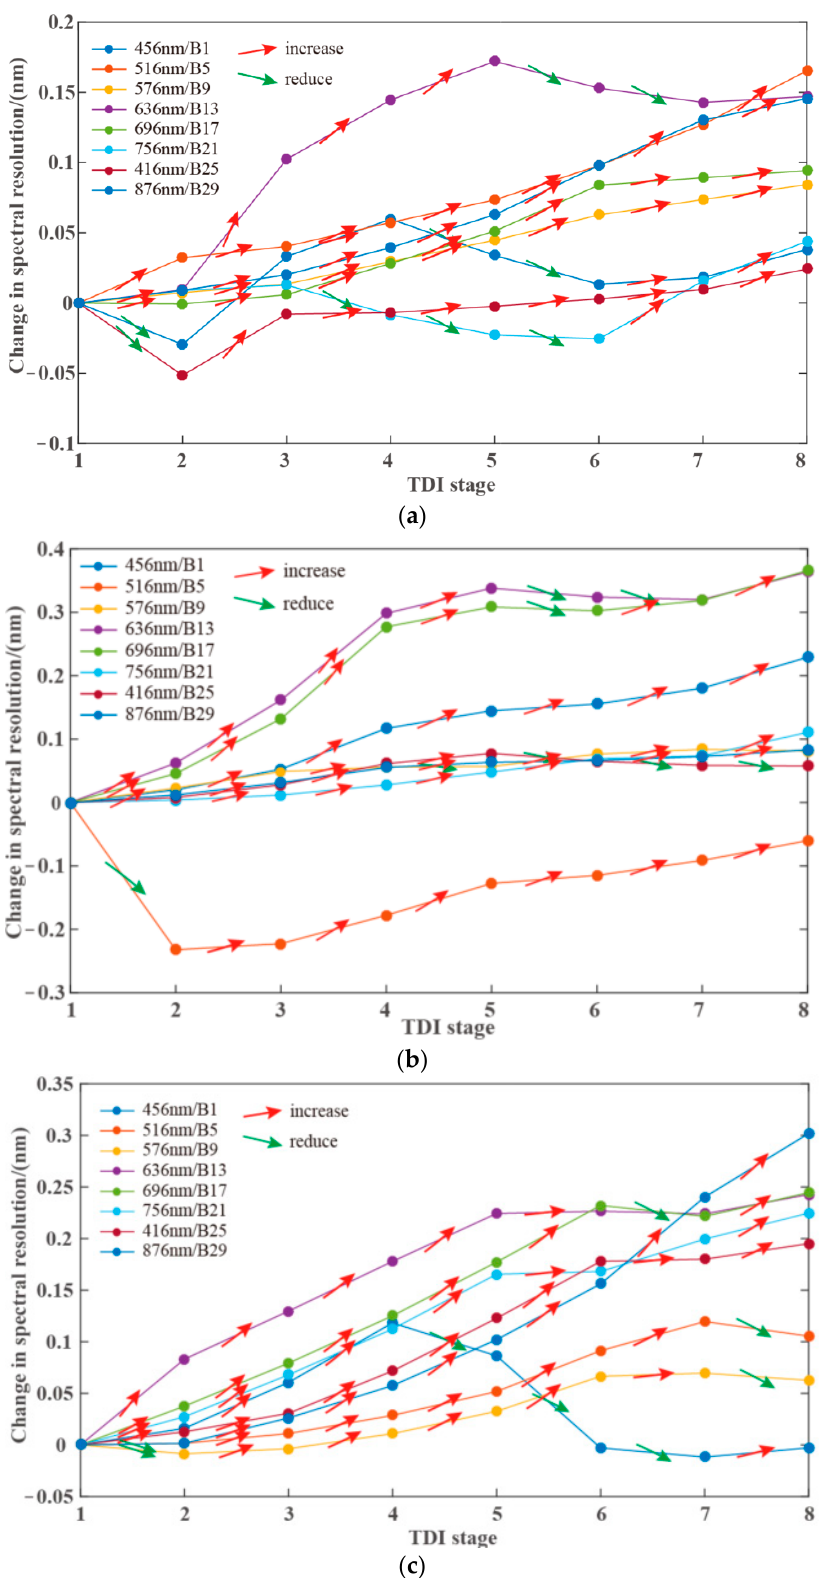
Figure 8. Spectral resolution of different integration stages of typical spectrum. ( a ) CMOS 1; ( b ) CMOS 2; ( c ) CMOS